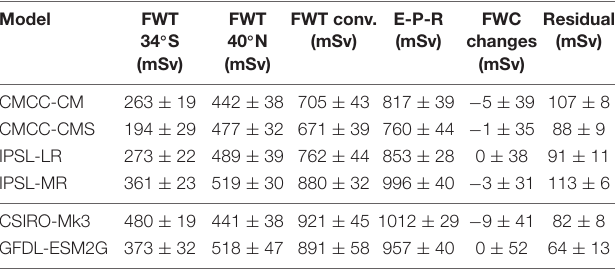
The second and third columns represent the total freshwater transport at 34 ◦ S and 40 ◦ N, respectively, whereas the fourth column corresponds to the freshwater transport convergence into this region. CMIP5 models above and below the thick solid line have negative and positive F ov34S , respectively. The transport signs are positive when the flux is into the budget